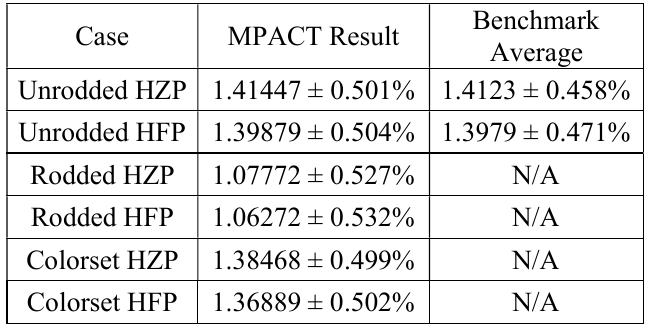
Table III. PWR lattice and colorset results: Effective neutron multiplication factor and uncertainty